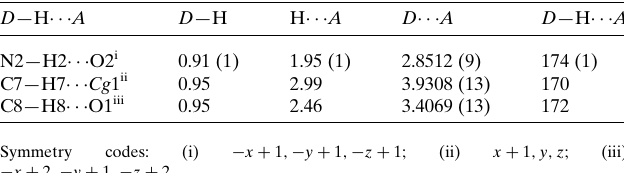
Table 1 Hydrogen-bond geometry (A˚ , (cid:3) ). Cg 1 is the centroid of the five-membered ring.